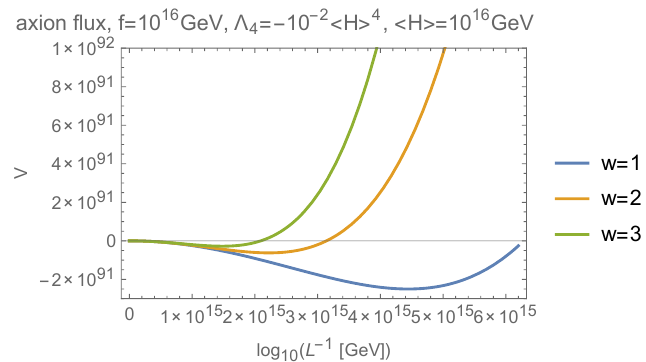
Figure 9 . The tree level potential of S 1 compacti(cid:12)cation of the SM with the high scale vacuum, eq. (3.27)